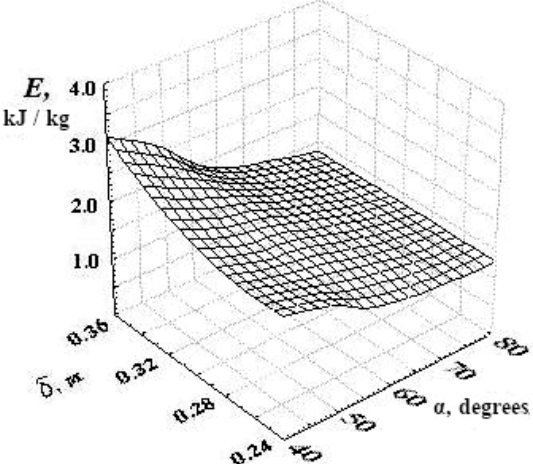
Figure 8. Dependence of energy consumption E on the angle, complementing up to 90° the angle of finger installation relative to radius α o and rotation frequency of the rotary finger working body ω at δ = const.